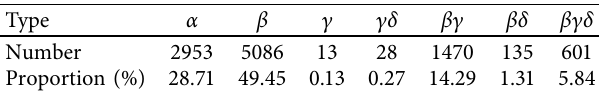
Figure 1: An example of compositing the morphological structure information of sunspots from the continuum image and the magnetic properties’ information from the magnetogram. The time is 20:00:00 UTon 8 June 2014. (a) The continuum image. (b) The magnetogram. (c) The composited image, in which the penumbra boundaries of the sunspot groups are contoured with green, and the positive umbra and the negative umbra are filled with red and blue, respectively. Table 1: The numbers and proportions of the samples of various